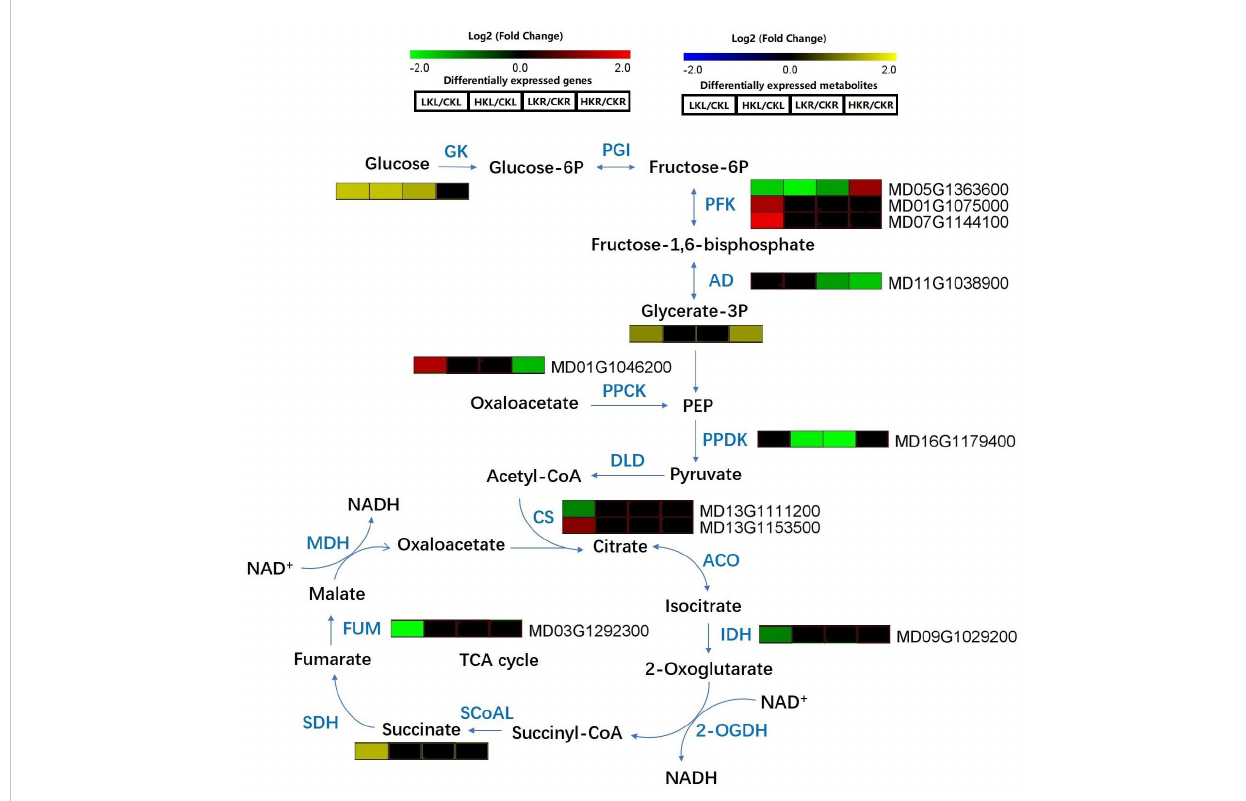
FIGURE 5 Carbon metabolites in apple leaves and roots under different K stresses. The boxes in the pathway represent DEGs or DAMs. Red and green represent upregulated and downregulated genes, respectively. Yellow and blue represent upregulated and downregulated metabolites,